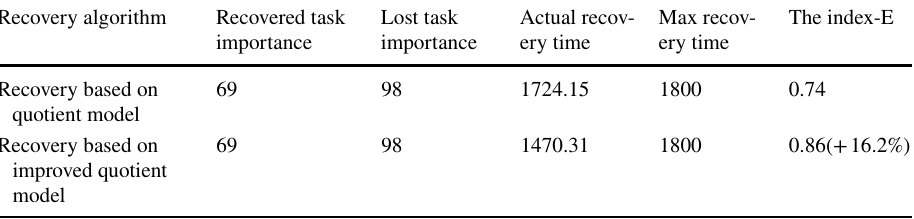
Table 11 Comparison of two recovery strategies and measurement